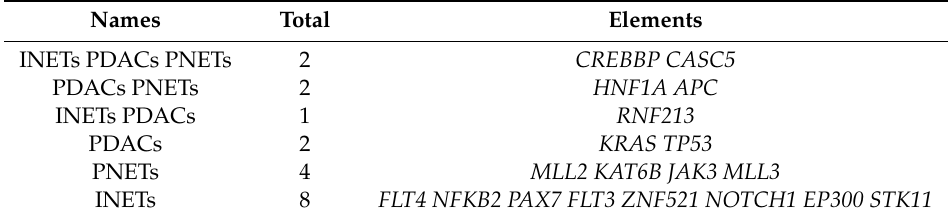
Figure 2. Venn diagram with variant numbers found in at least 40% of samples in all three tumor types selected by the parallel sequencing of 13 neuroendocrine tumors (nine PNETs and four INETs) and 8 ductal adenocarcinomas of the pancreas. Table 3. The most frequently mutated (i.e., with a frequency of more than 40% samples) genes in the three tumor types.